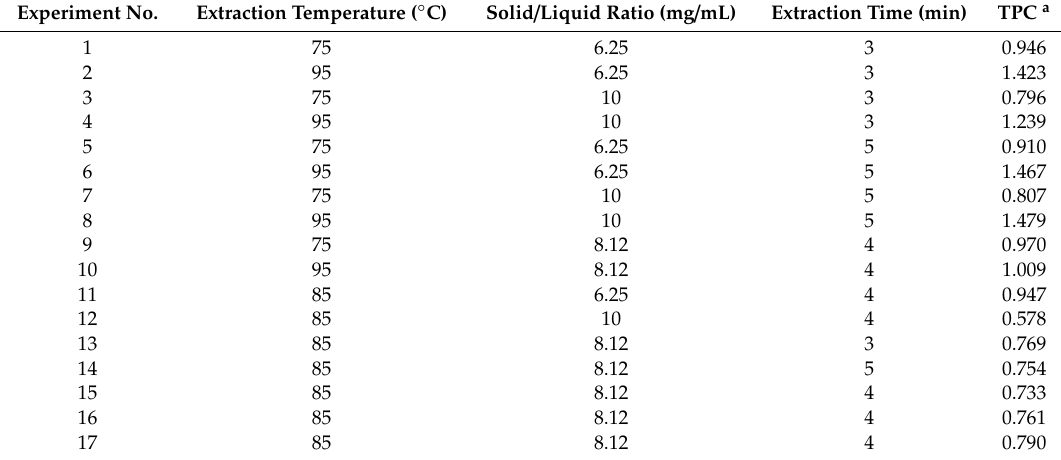
Table 1. Optimization of microwave-assisted extraction of bamboo shoots using response surface methodology: central composite face-centered (CCF) design matrix and observed responses. Experiment